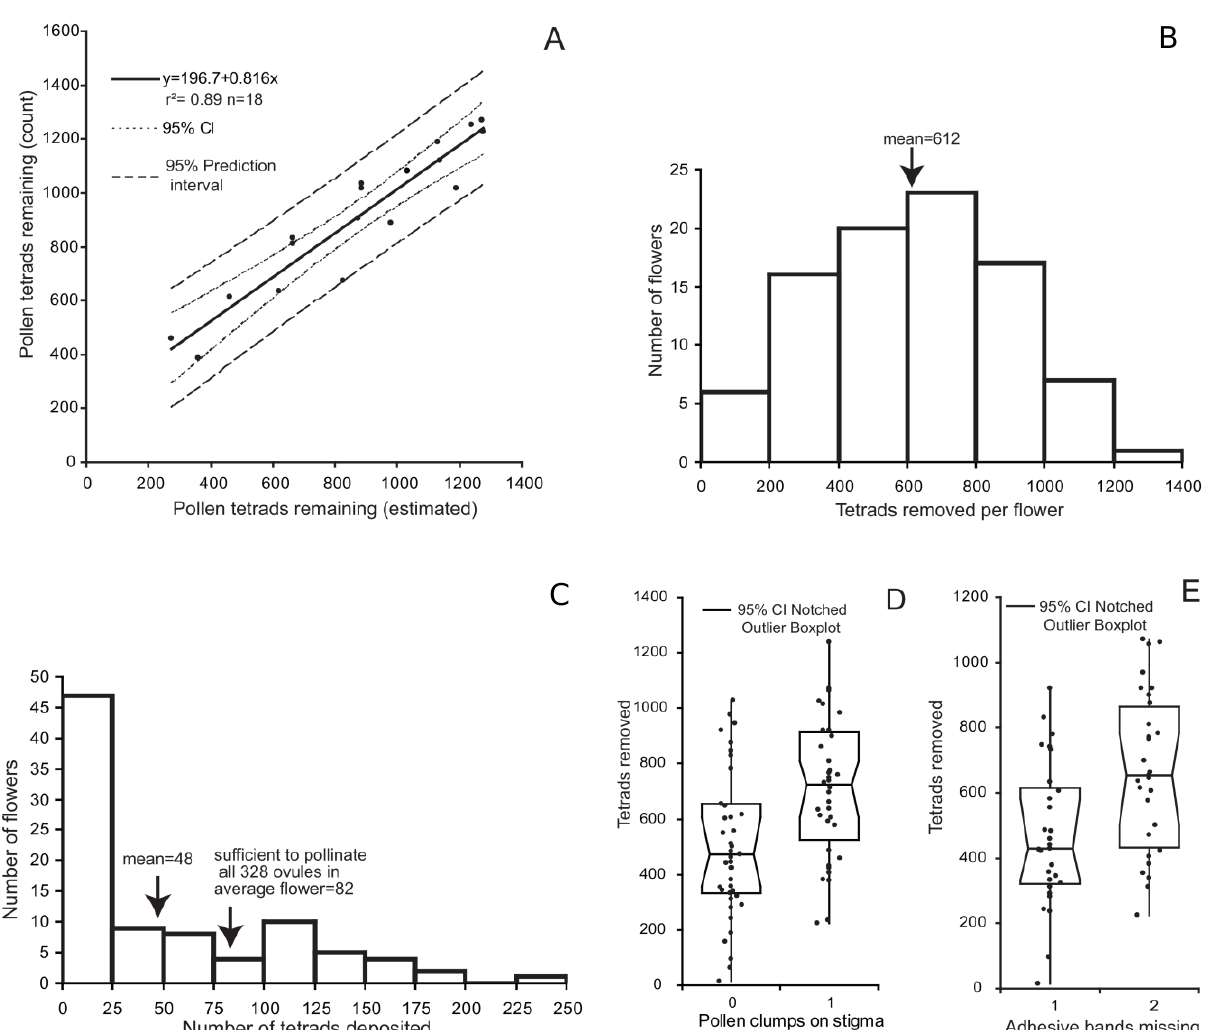
F IGURE 3. Pollen removal and deposition in 90 flowers of Apocynum cannabinum pooled from three populations (Table 1). A. Linear regression of count of pollen tetrads remaining in 18 post-anthesis flowers as a function of estimates of pollen tetrads remaining calculated by scoring the pollen content of each pollen sac and multiplying by the pollen content of a pre- anthesis bud (See “Pollen Removal” in Materials and Methods). B. Distribution of tetrad removal per flower. C. Distribution of tetrad deposition per flower. D. Comparison of tetrads removed per flower in flowers with 0 versus 1 pollen clump deposited on the stigma. E. Comparison of tetrads removed per flower in flowers with 1 versus 2 adhesive bands